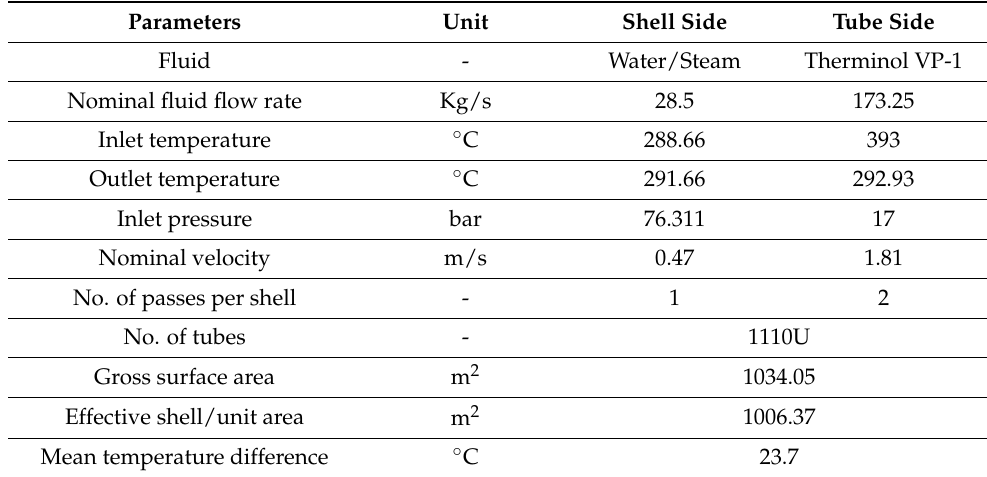
Table 4. The specifications of the HTF heat exchangers. Parameters Unit Shell